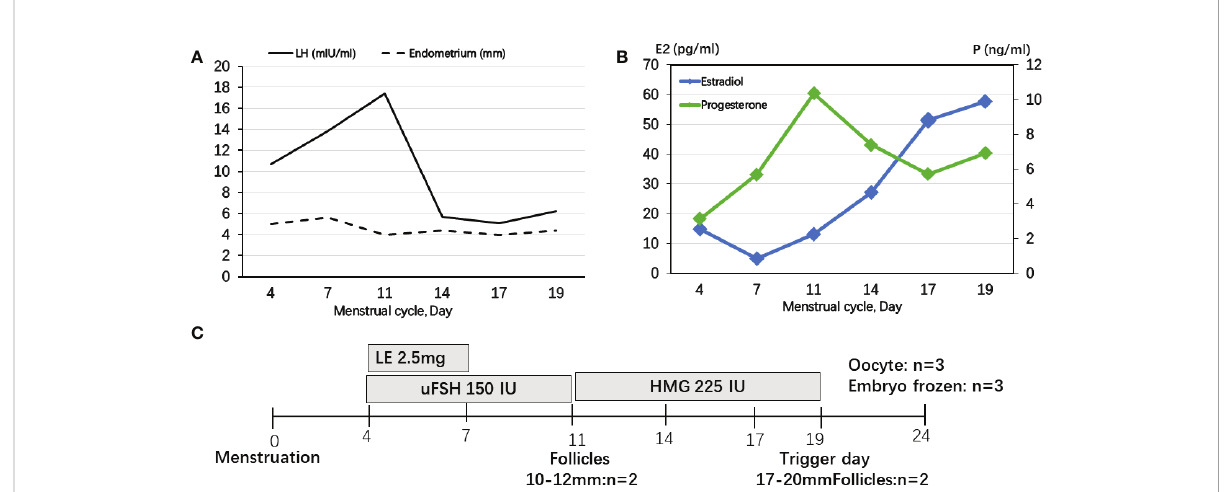
FIGURE 1 Controlled ovarian stimulation cycle in patient 1. (A) LH levels were slightly elevated to the maximum of 17.42 mIU/ml at day 11 of menstrual cycle, but decreased thereafter, but the endometrium was less than 6 mm during COH. (B) Serum E2 levels were only modestly increased and P levels were sustained above 5 ng/ml. (C) A protocol with letrozole (LE) and gonadotropins was used in patient 1. Ovulation was triggered by HCG on Day